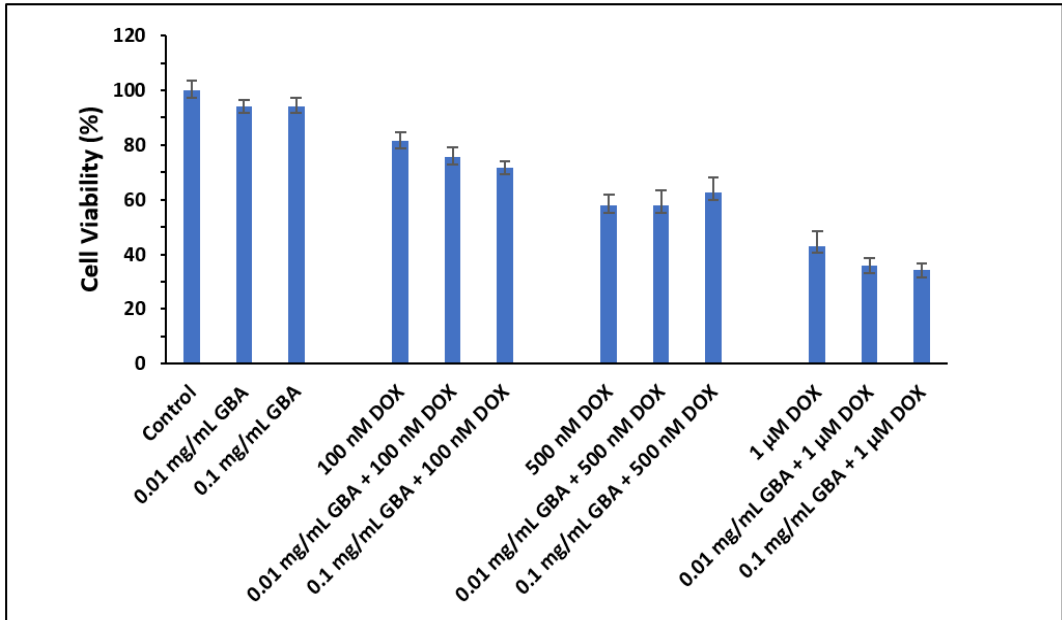
Figure 11. Effect of DOX-loaded GBA on the viability of MCF-7 cells seeded at 25,000 cells/well after 48 h of treatment. Approximately 25,000 MCF-7 cells were seeded per well in 24-well plates. Cells were treated after 24 h with (DOX) doxorubicin (100 nM, 500 nM, or 1 µM) in free form and in complexation with GBA at 0.01 mg/mL or 0.1 mg/mL. Cell viability was calculated using the absorbance of untreated cells as 100%. Table 6. Cytotoxicity enhancement of DOX-loaded GBA in MCF-7 cells (25.000/well). GBA Containing Different Concentrations of DOX